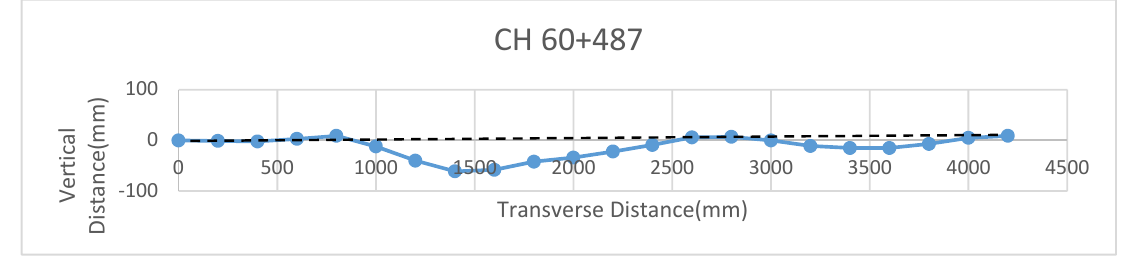
Figure 16. Transverse profile of 60 + 487 km.